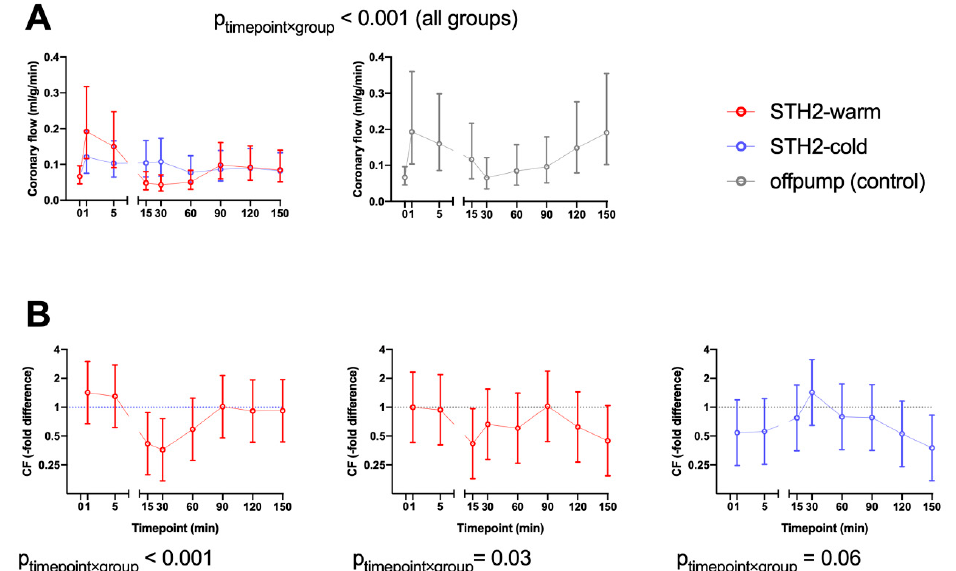
Figure 3. Changes of coronary flow (CF) during reperfusion. After baseline adjustment, the change over time of coronary flow ( A ) during reperfusion was differently affected by STH2-warm cardioplegic solution and STH2-cold cardioplegic solution (timepoint x group p < 0.001). After 15 min of reperfusion, pigs receiving STH2-warm showed a 0.41-fold altered coronary flow compared to the STH2-cold group (95% CI 0.20–0.89). After 30 min, a similar reduction was observed (0.35-fold; 95% CI 0.17–0.76). At further timepoints, CF values did not significantly differ between groups. After 15 min, pigs receiving STH2-warm also exhibited 0.42-fold (95% CI 0.18–0.97) lower CF values compared to the off-pump control ( B ). Values are estimated geometric means ( A ) or estimated -fold differences ( B ) with 95% confidence intervals, n = 5–6/group. CF: coronary flow.